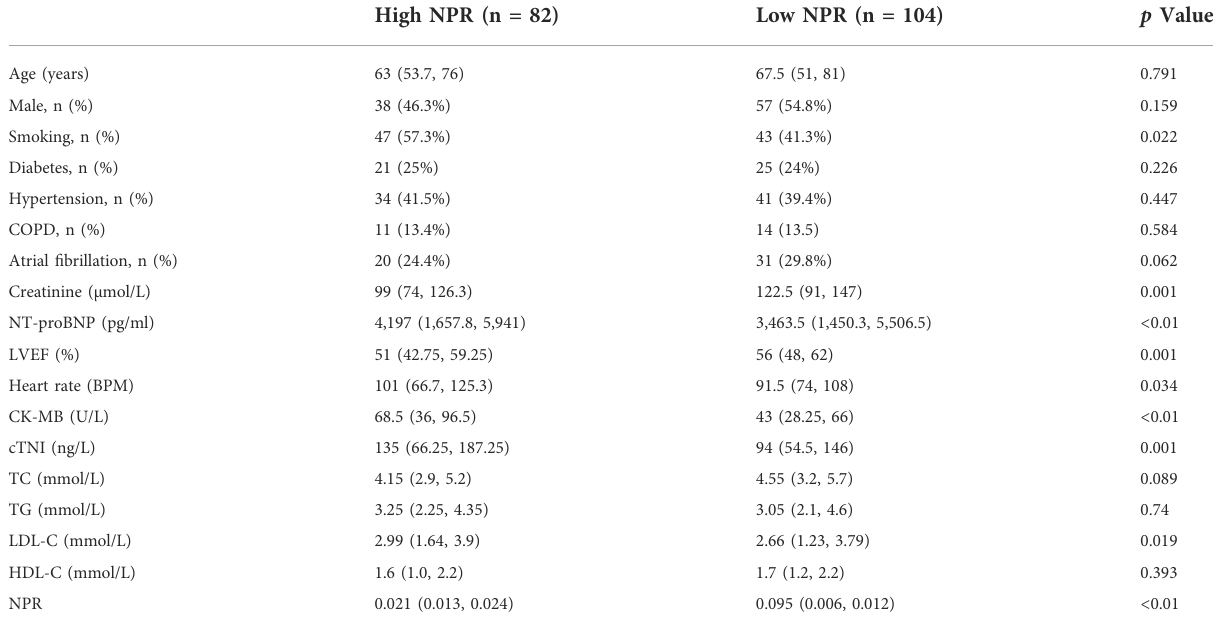
TABLE 1 Baseline characteristics of patients in the low and high NPR groups.